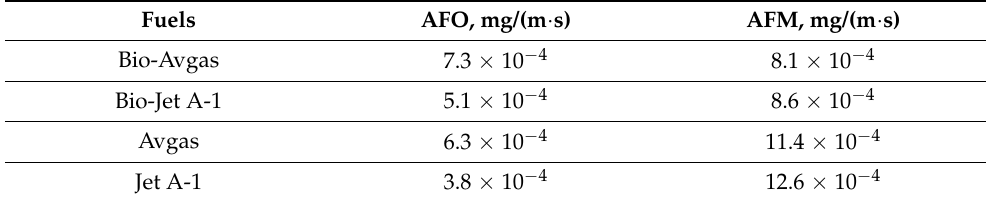
Table 7. Leakage rate of fuel λ , mg/(m · s).